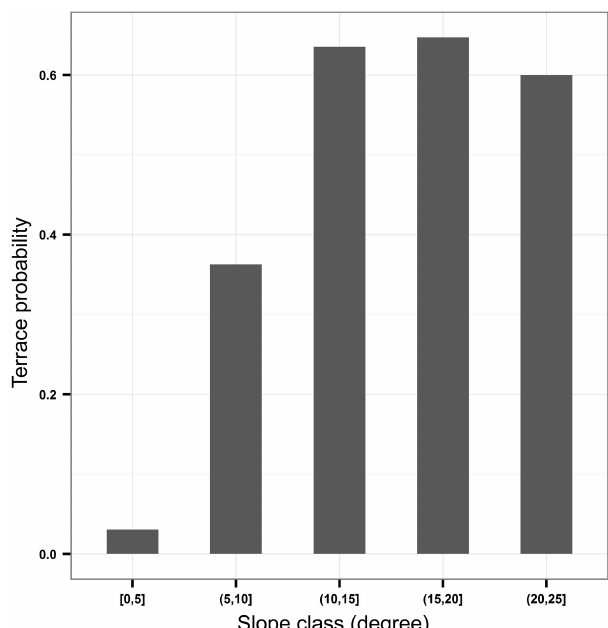
Figure 5. Proportion of farmland on the CLP that is terraced for dif- ferent slope classes (GEps observations). The probability that land is terraced strongly increases up to a slope gradient of ca. 10 ◦ af- ter which it remains more or less constant up to a slope gradient of ca. 25 ◦ . Very steep slopes are somewhat less frequently terraced, possibly because the marginal agricultural return does not warrant the terracing effort.